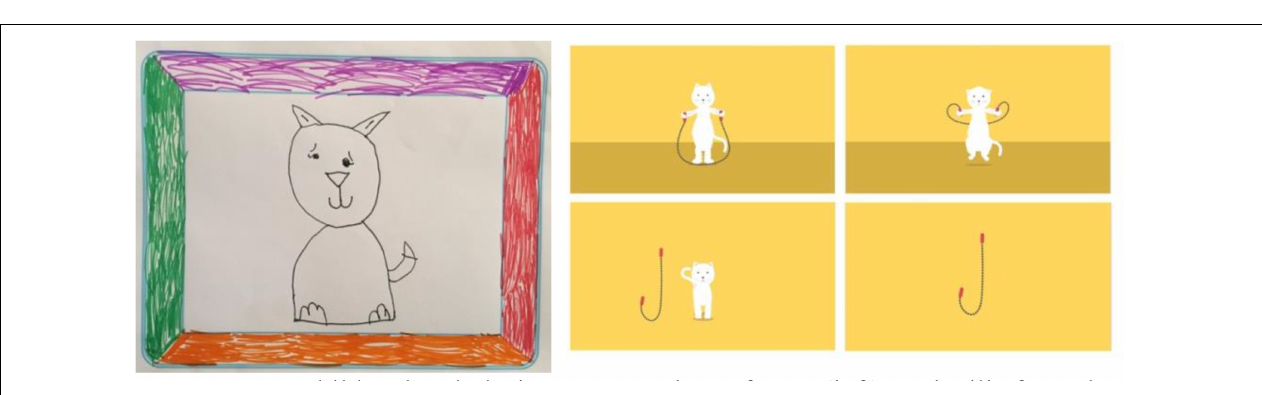
FIGURE 9 | A child’s sketch during User Study 1 of a cat (left) , and stills from the final animation titled “J is for Jumping” (right) .